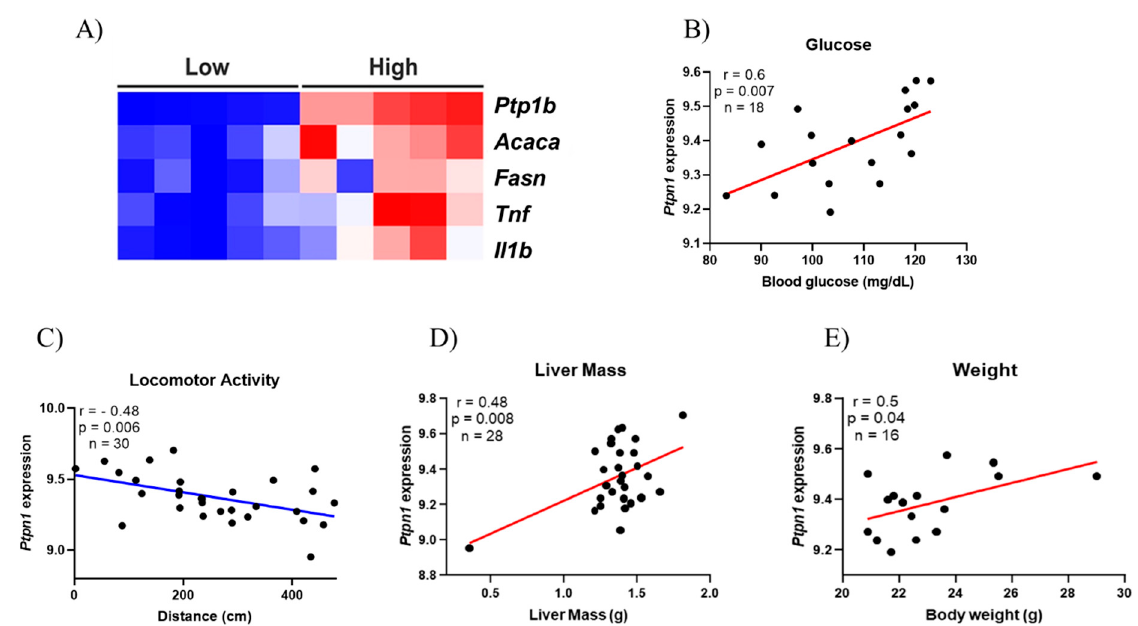
Figure 4. Bioinformatics analysis. Heatmap illustrating the lower and higher expression of Protein-Tyrosine Phosphatase 1B (PTP1B) and the influence in lipogenic genes [Acetyl-CoA Carboxylase (ACC) and Fatty Acid Synthase (FAS)] and inflammatory genes [Tumor Necrosis Factor (TNF) and interleukin 1 β (IL1 β )] on human liver tissue. The figure illustrates clusters between the groups Low and High showing that they are directly related ( A ); Correlation between PTP1B gene expression and Blood Glucose levels ( n = 18) ( B ); Correlation between PTP1B gene expression and locomotor activity ( n = 30) ( C ); Correlation between PTP1B gene expression and liver mass ( n = 28) ( D ); Correlation between PTP1B gene expression and body weight ( n = 16) ( E ).